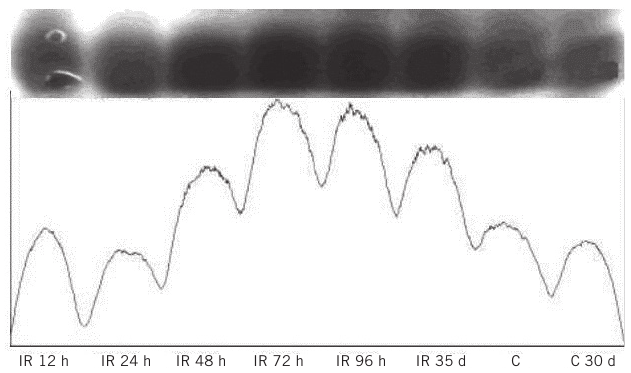
figurE 2 − Electrophoretic profile of subgroup SGA after whole-body exposure to 5 Gy SGA: subgroup albumin.